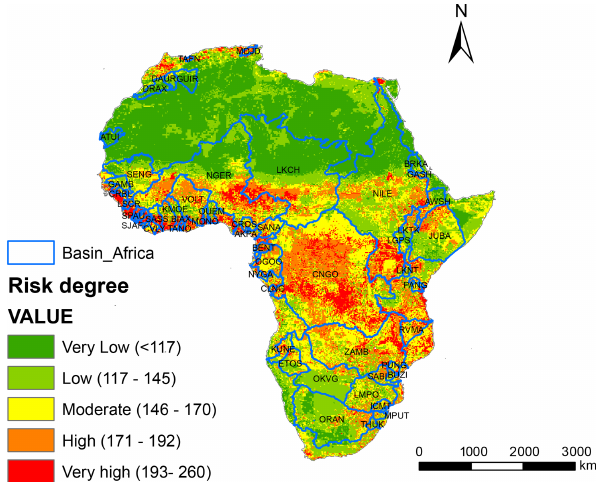
Figure 1. Groundwater pollution risk map under different trans- boundary